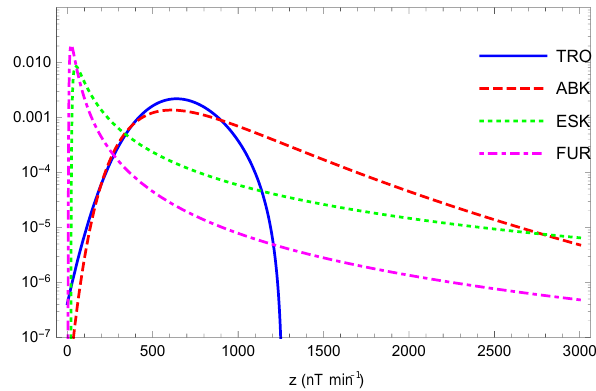
Figure 2. Probability density functions for four distributions esti- mated from geomagnetic data at TRO, ABK, ESK, and